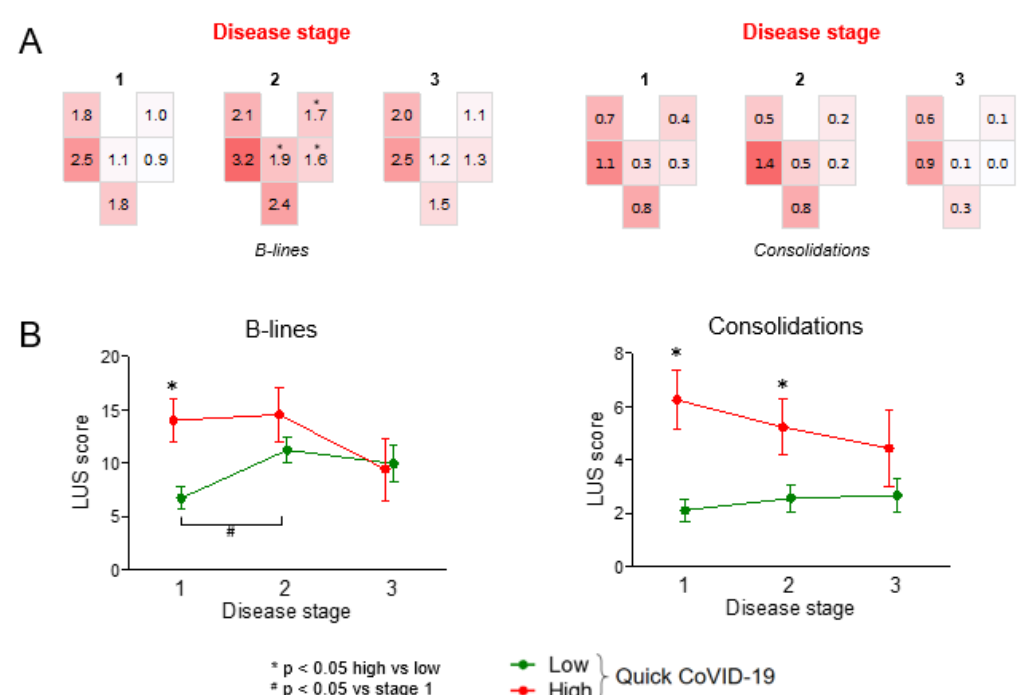
Figure 2. LUS patterns according to disease stage. ( A ) Geographical LUS patterns according to disease stage (1: day 0–6; 2: day 7–13; 3: day 14+). * p < 0.05 versus stage 1. ( B ) Time trend of the total B-line and consolidation score in the two groups of patients divided according to the quick COVID-19 severity index (* p < 0.05 high vs. low; # p < 0.05 vs. stage 1).